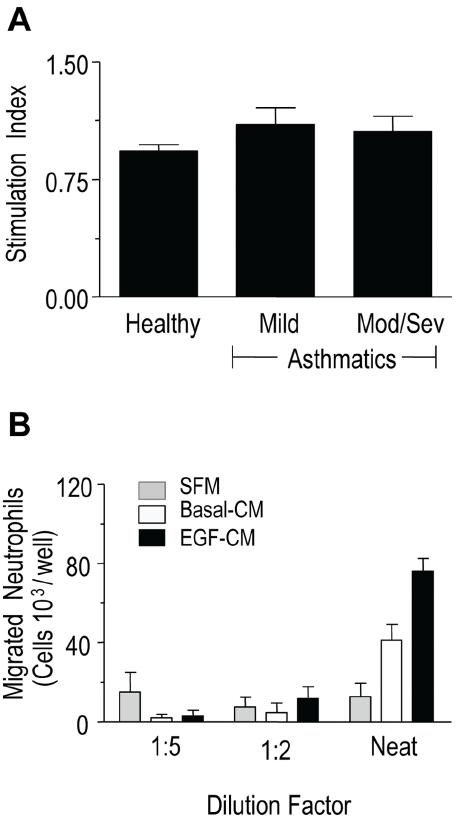
Figure 1. Effects of EGF on primary bronchial epithelial cell (PBEC) proliferation and mediating neutrophil chemotaxis. (A) PBECs were exposed to EGF and proliferation was assessed using a colorimetric assay based on methylene blue uptake and release ( see Results section; pilot experiments ). The stimulation index derived by dividing the methylene blue uptake of cells exposed to EGF (10 ng/ml, 24 h) by the uptake of unexposed cells were , 1 in all subject groups, suggesting that, EGF did not increase the numbers of epithelial cells ( n =3–5 donors from each group). (B) Dose-dependency of chemotactic responses to PBEC conditioned media. PBECs were stimulated with EGF (10 ng/ml) to generate EGF-CM or left untreated (Basal-CM). Neutrophil chemotaxis induced by the CM was compared to SFM as described in Methods . The chemotactic activity was concentration-dependent with a maximal effect observed when using neat CM ( n =3